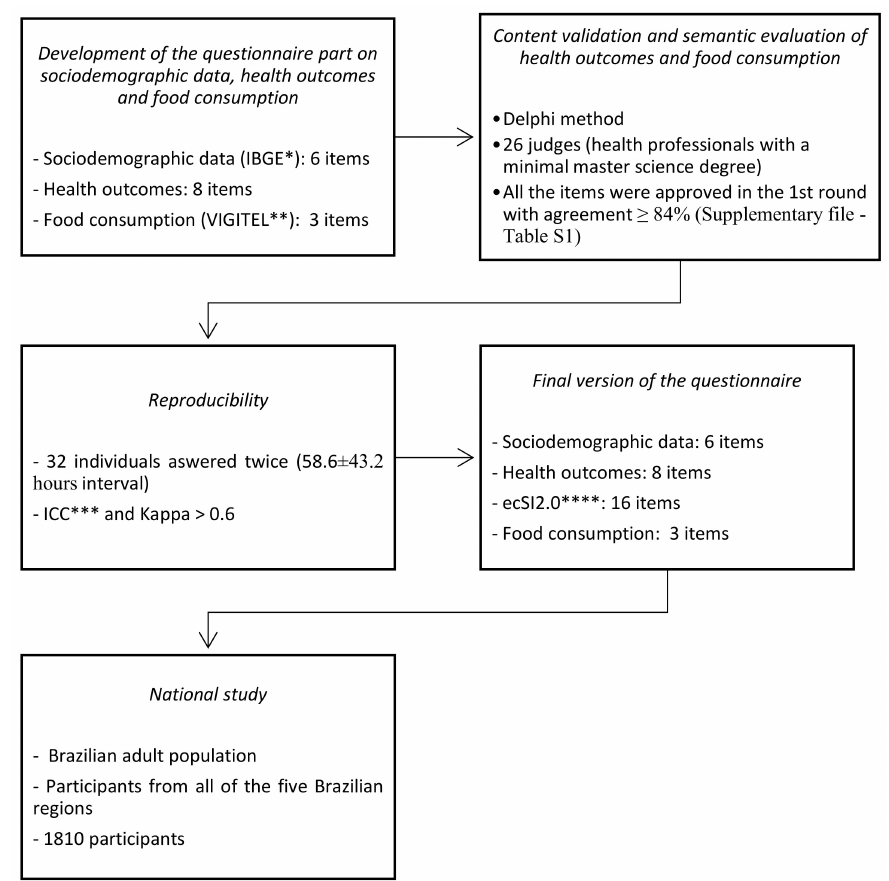
Figure 1. Flowchart of the steps to construct and validate the final version of the questionnaire and national application. * IBGE: Brazilian Institute of Geography and Statistics; ** VIGITEL: Brazilian Surveillance System of Risk and Protection Factors for Chronic Diseases by Telephone Inquiry”; *** ICC: Intraclass correlation coe ffi cient; **** ecSI: Satter Eating Competence